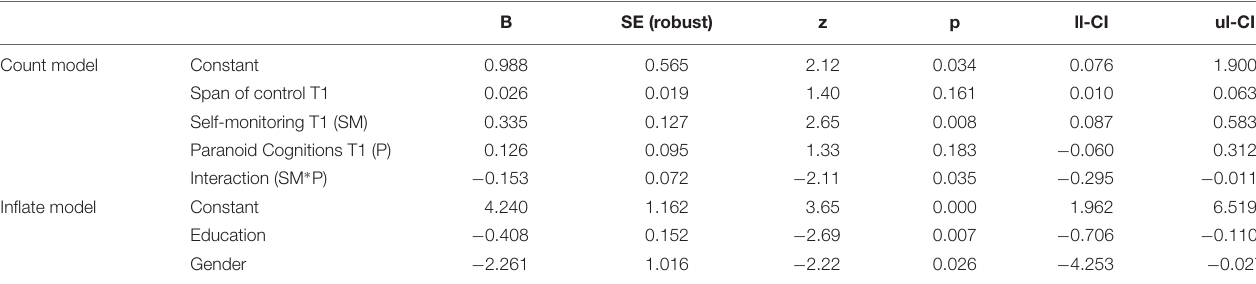
TABLE 2 | A zero-inflated negative binomial regression to explain (a) the count variable changes span of control (span of control at T2 while controlling for span of control at T1) and (b) the excessive amount of zeros in the count variable. B SE (robust) z p ll-CI